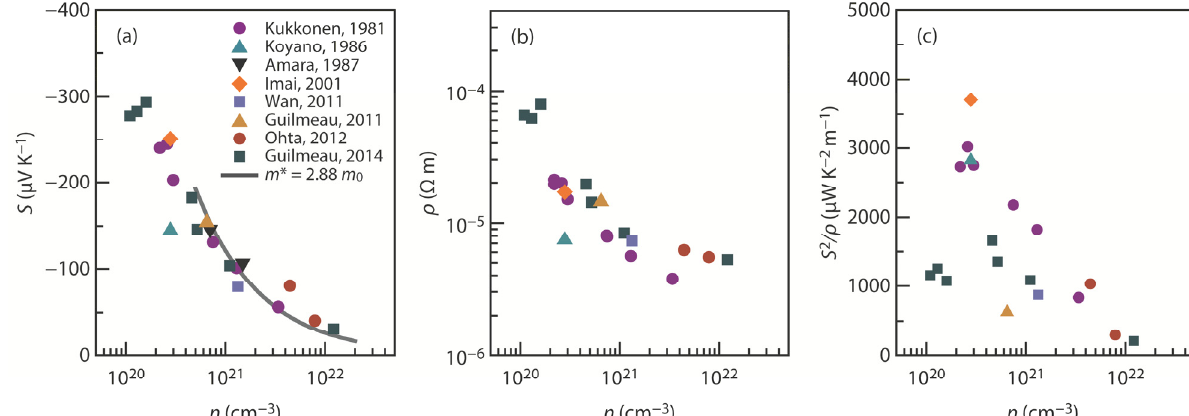
Figure 6. ( a ) Seebeck coefficient ( S ); ( b ) electrical resistivity ( ρ ); and ( c ) power factor ( S 2 / ρ ) plotted against the carrier concentration ( n ) at 300 K in the in-plane ( ab -plane) direction for Ti 1+ x S 2 [29,30,41,43,44,75–77]. The solid line in ( a ) represents the values